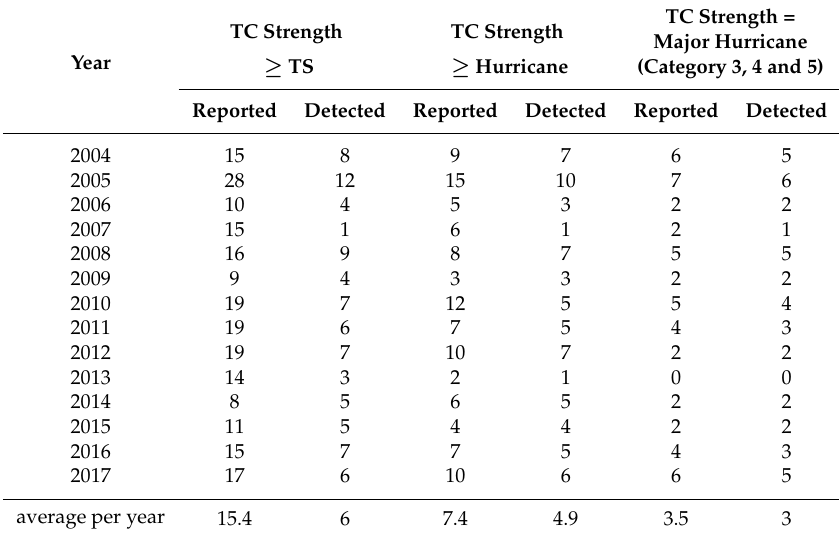
Table 2. Number of TCs for three TC categories during the period 2004–2017 obtained using either observed data (column Reported ) or the detection and tracking algorithms (column Detected ). Observed data are from the free online encyclopedia Wikipedia (see for example https://en.wikipedia.org/wiki/ 2004_Atlantic_hurricane_season for the Atlantic hurricane season in 2004; last accessed on 18 February 2019). TS: tropical